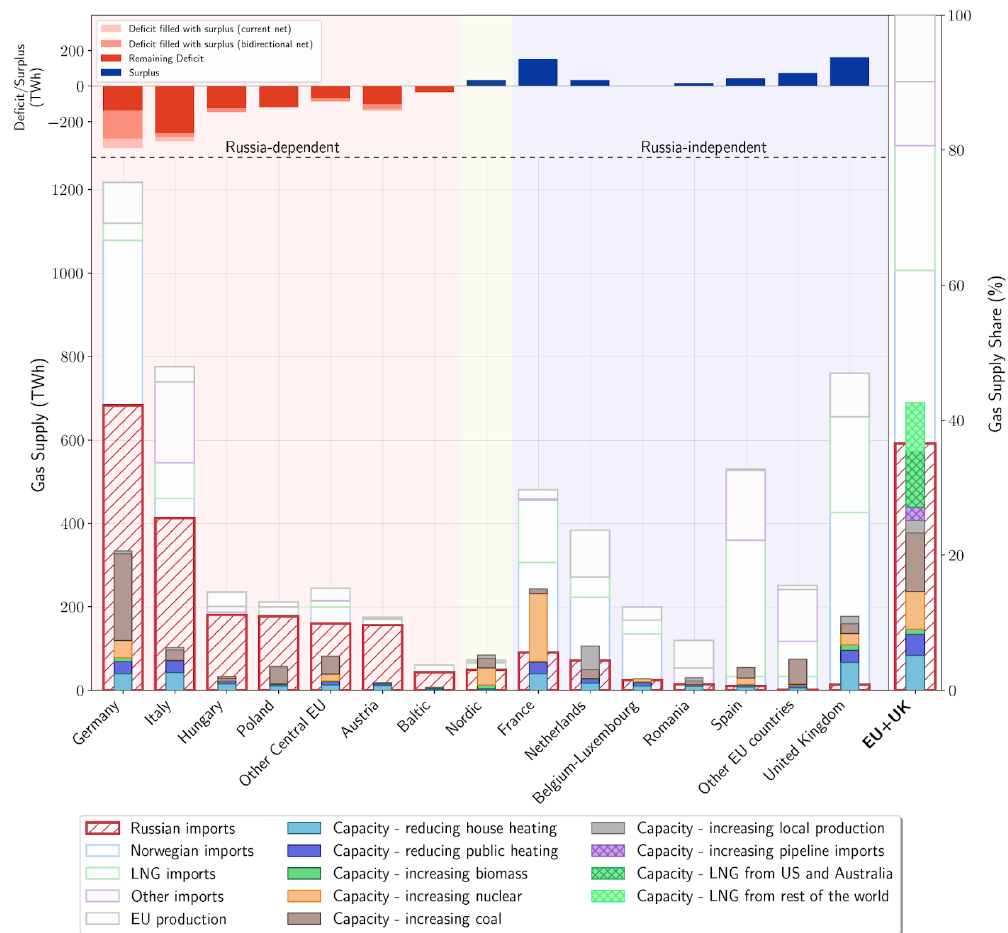
Figure 7. The Russian gas gap and potential solutions in the EU. The wider bars display the gas supply from Russia (red hatching), Norway, LNG imports, other pipeline imports, and EU gas production. The narrower bars present the maximal capacity from different sectors to potentially fill the gap (see text). The EU and UK gap is presented as a percentage of total consumption (right y axis). The top bars present the deficit and surplus, and the amount can be transferred inside the EU. “Baltic” includes Estonia, Latvia, and Lithuania. “Nordic” includes Denmark, Sweden, and Finland. “Other central EU countries” includes Slovakia, Slovenia, Czechia, and Croatia. “Other EU countries” includes Ireland, Bulgaria, Portugal, and Greece. The Russia-dependent countries have high Russian gas shares ( > 20%) with remaining gaps. Russia-independent countries have low Russian gas shares ( < 20%) with no remaining gaps. Nordic countries have higher Russian gas shares but no remaining